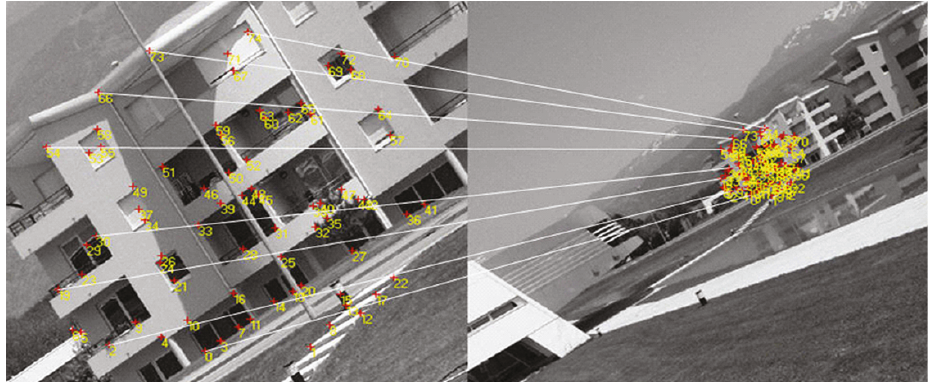
Figure 9: Matching result for image pair Residence (frames 0 and 9 of “Resid” sequence). The scale factor is 4.7, and the rotation angle is 5 degrees.